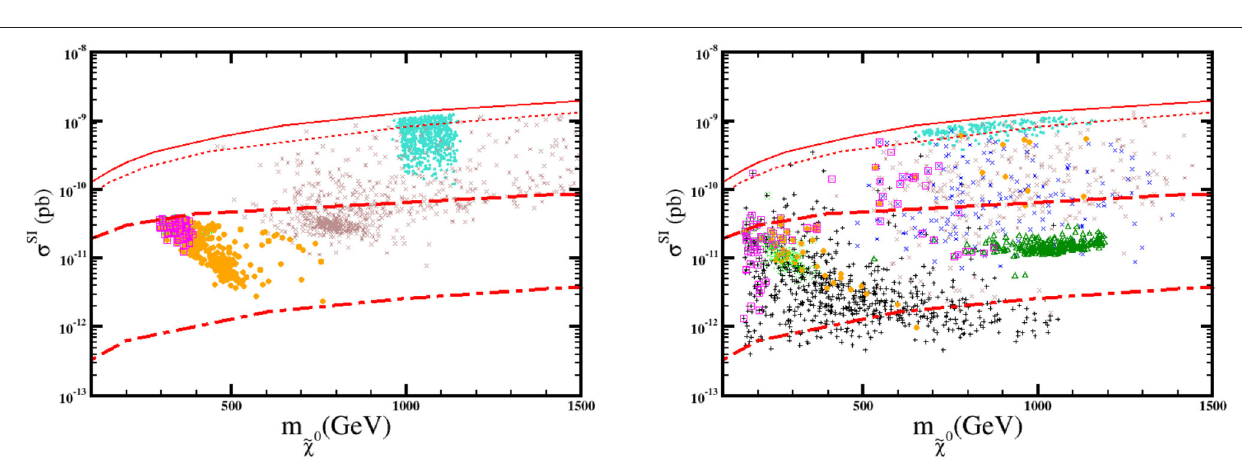
FIGURE 2 | Scatter plots for the SI neutralino-nucleon cross section, for SO(10) (left) and 4-2-2 (right). The red line corresponds to the Xenon-1T bound [6] while the dotted line includes their latest announcement. The dash and the dot-dash lines correspond to the projected sensitivities from LZ [4] and DARWIN [7]. Symbols and color codes are the same as in Figure 1